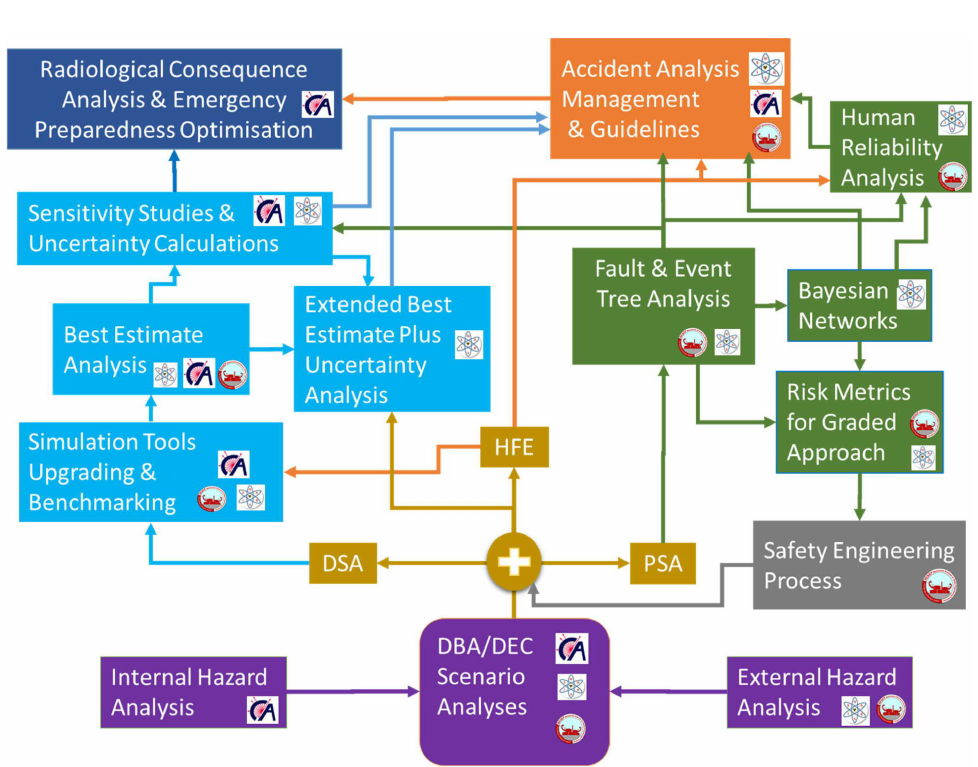
Fig. 8. Focuses and interaction areas of the three projects (marked with the project